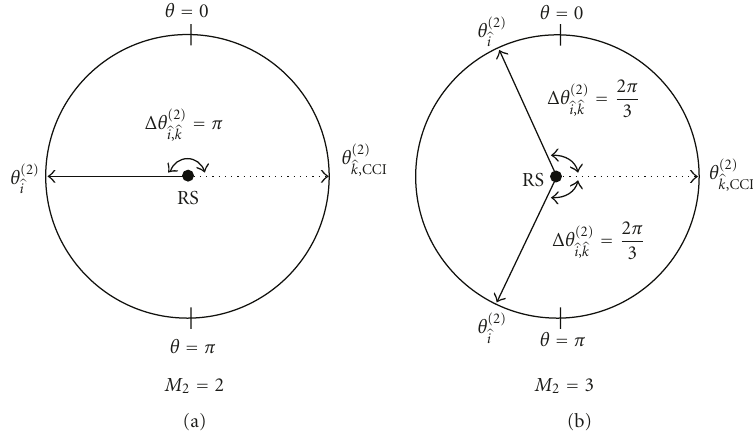
Figure 4: Design concept of the coordinated eigen-beamforming with physical